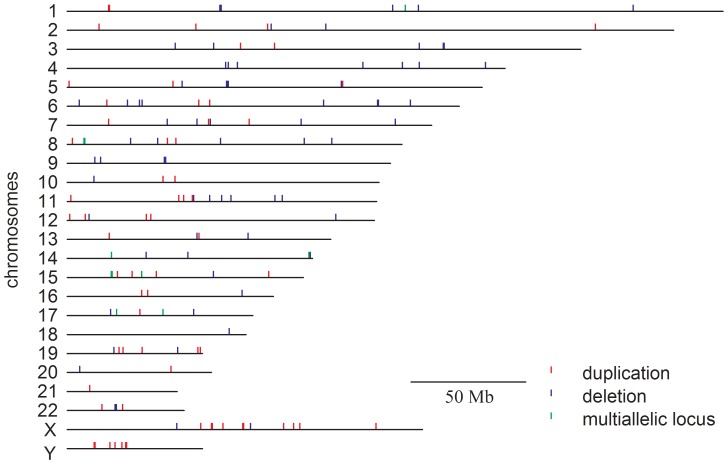
Structural variation map of Tibetan samples.The schematic summarizes the distribution of duplications, deletions and multi-allelic loci on each human chromosome.